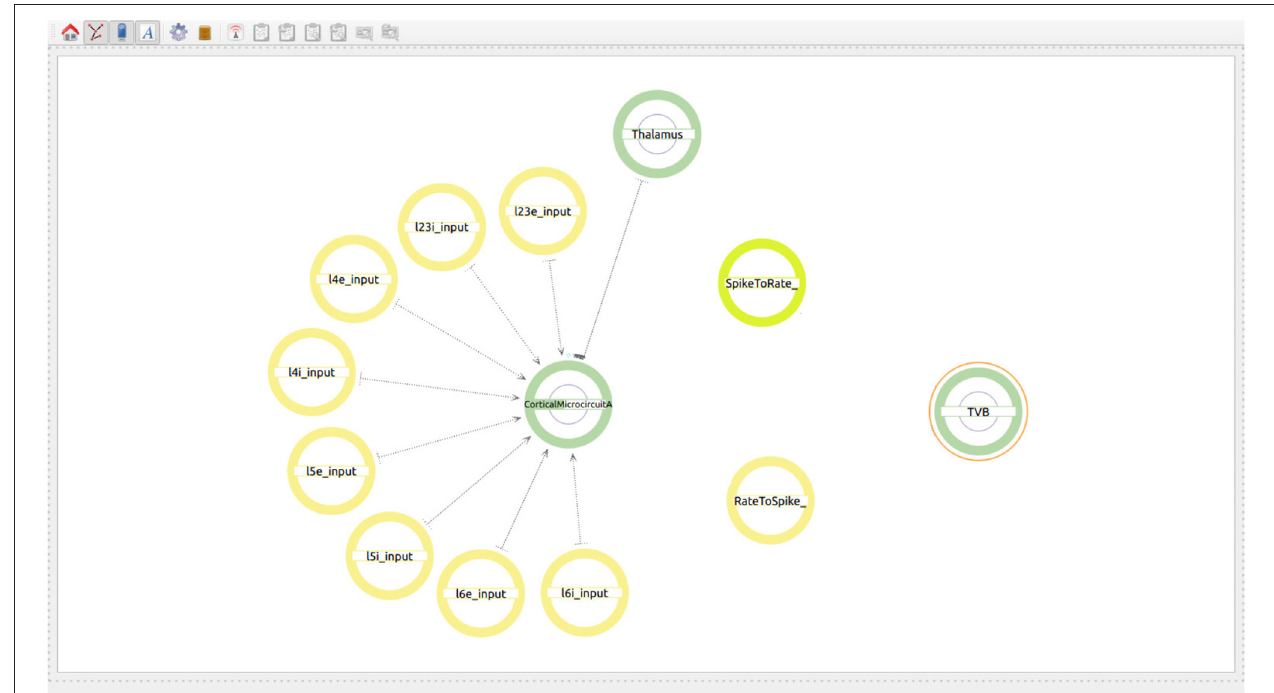
FIGURE 8 | Modeling of the co-simulation use case starting with the super-population for the brain region represented by NEST, the super-population for the brain regions represented by TVB and the translator modules which have the task of translating spikes to rates and vice versa.